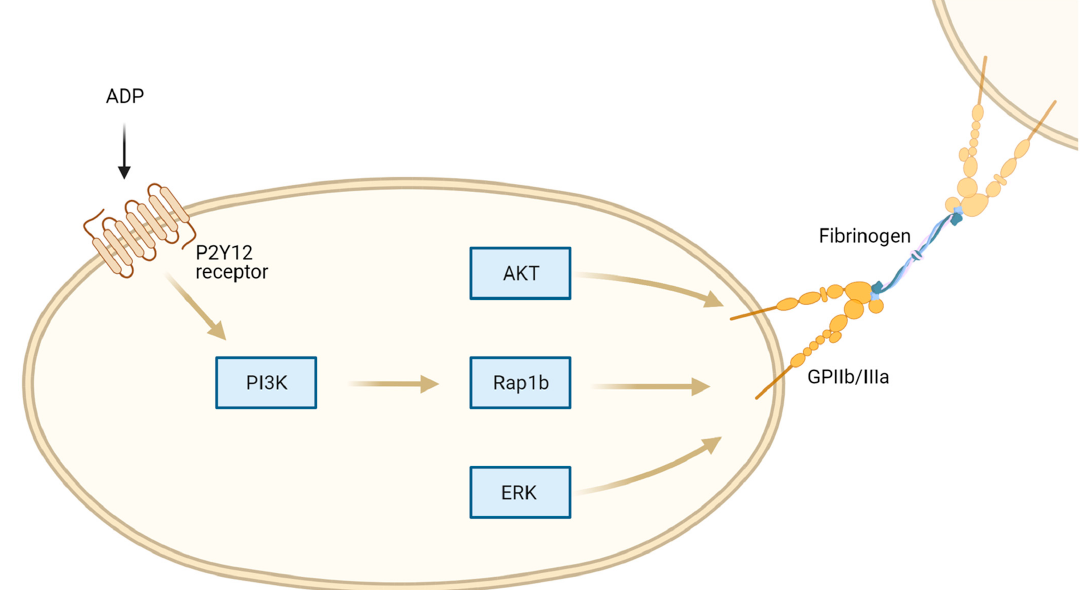
Figure 2. P2Y 12 receptor in platelet activation. ADP binding to P2Y 12 receptor leads to Phosphoinositide 3-kinase (PI3K) activation and subsequent glycoprotein (GP) IIb/IIIa activation via AKT, Ras-related protein (Rap-1b, and extracellular-signal regulated kinase (ERK) pathways.